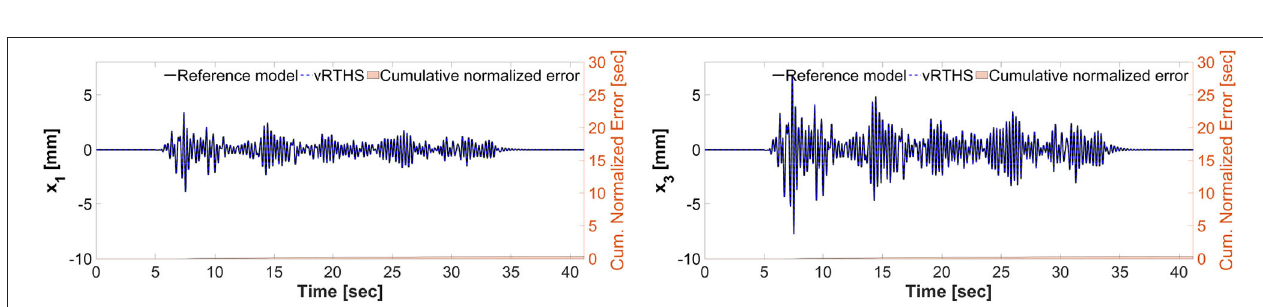
FIGURE 15 | Study 3 (Case 1 and Case 4): exact (off-line) indicators, run-time sensitivity indicators, and corresponding envelopes.